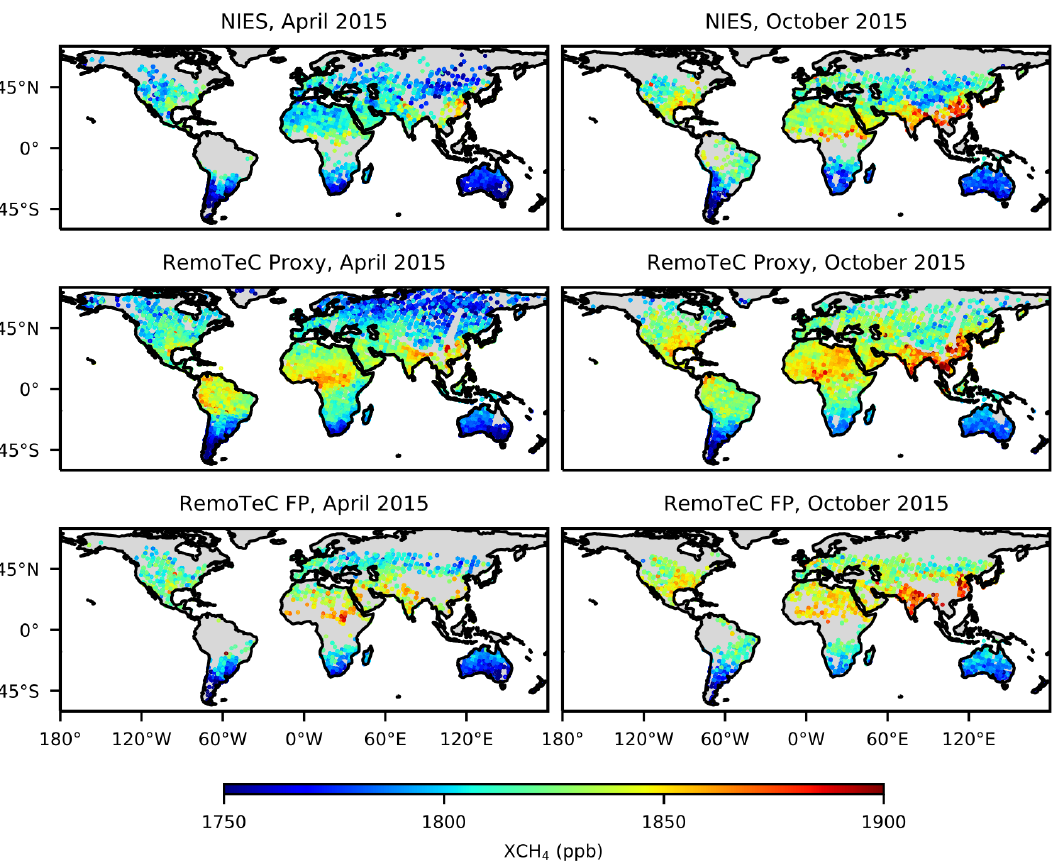
Figure 1. GOSAT nadir-mode XCH 4 observations for: NIES ( top panel); RemoTeC Proxy ( middle panel) and RemoTeC FP ( lower panel), for April 2015 (left column) and October 2015 (right